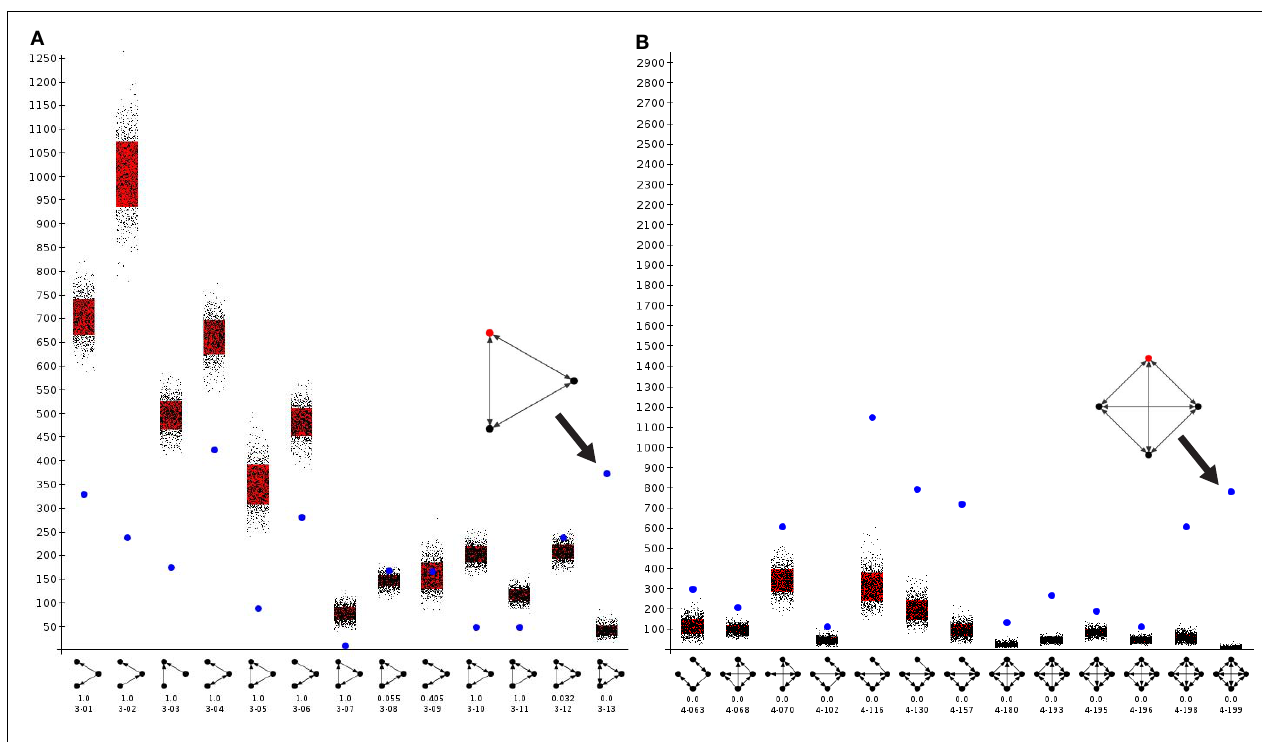
FIGURE 7 | Motif analysis of the condensed intrinsic amygdala network. Frequency of motifs in the intrinsic amygdala network is indicated by a blue dot. Frequencies of motifs in rewiring randomizations are indicated by black points. Red bars show the standard deviation of